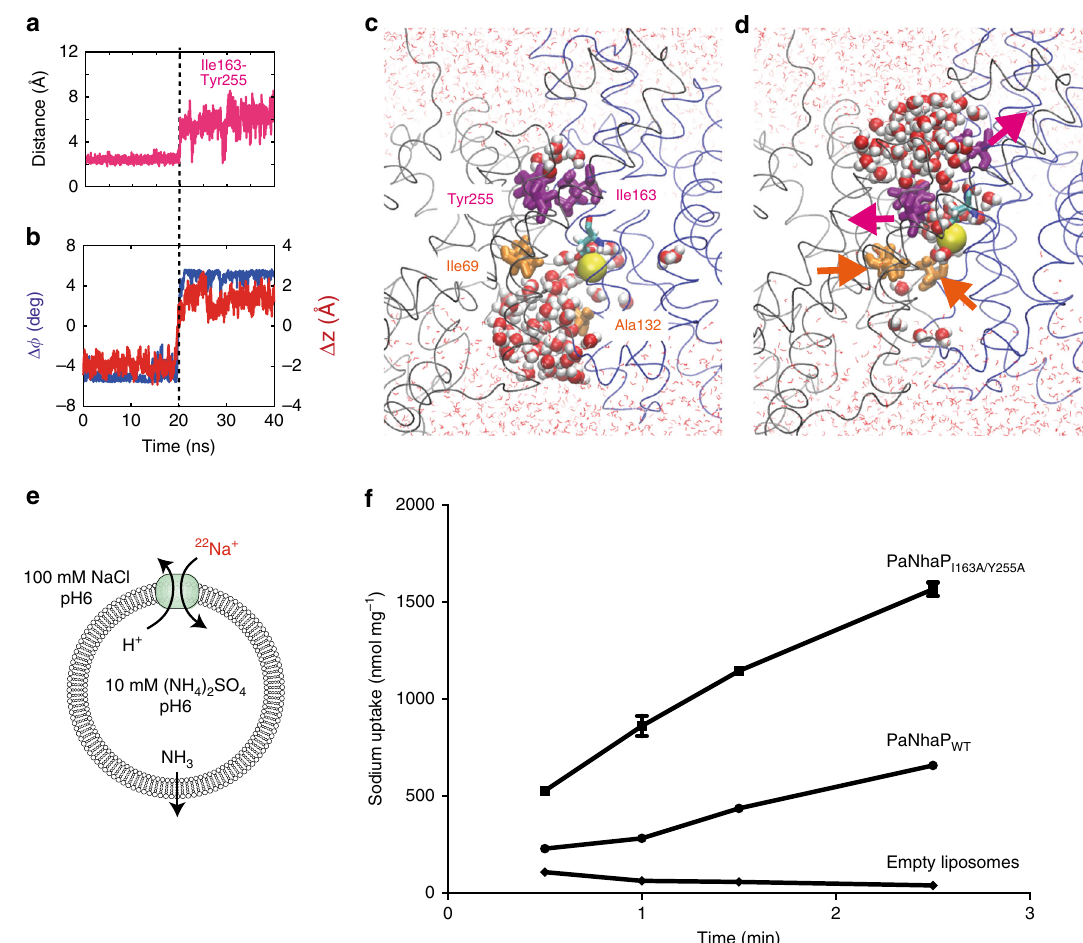
Fig. 3 Hydrophobic gate. a Minimum distances of residue pairs forming the hydrophobic gate (magenta) in transition path at 100 °C with Na + bound. b Concomitant changes of the two structural order parameters for domain motion (angle: blue, left scale; vertical displacement: red, right scale). c Structure of inward-open state, with inside access (orange) open and outside access (magenta) closed. Asp159 is shown in stick representation, and the bound Na + as yellow sphere. Water molecules within 15 Å of the two carboxyl oxygen atoms of Asp159 are shown as spheres; other water molecules are shown as lines, and the protein backbone in gray and blue. d Structure of outward-open state. Arrows indicate opening and closing motions. e Transport assay of PaNhaP wild type and I163A/Y255A mutant reconstituted in liposomes. Transport was initiated by the dilution of (NH 4 ) 2 SO 4 -loaded proteoliposomes into reaction buffer. f Ef fl ux of NH 3 from the liposomes creates a pH gradient that drives 22 Na uptake by PaNhaP. With 512.6 nmol min − 1 mg − 1 , the